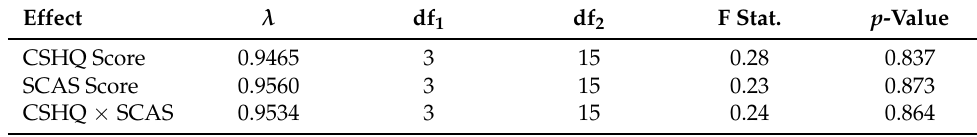
Table 7. Results of MANOVA analysis on cortisol levels, sleep quality and anxiety socres. Effect λ df 1 df 2 F Stat. p -Value CSHQ Score